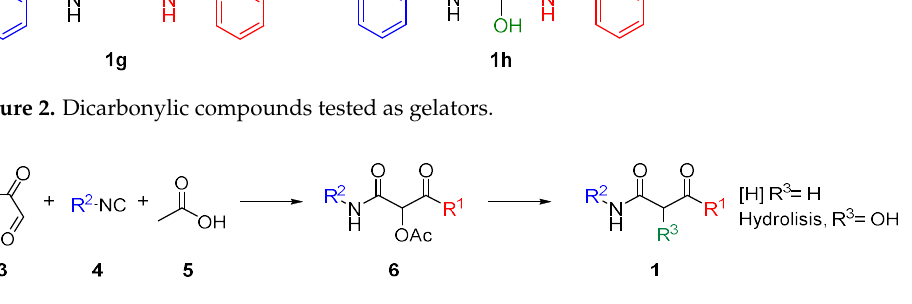
Figure 1. General structures of two type of structures tested in gelification essays.